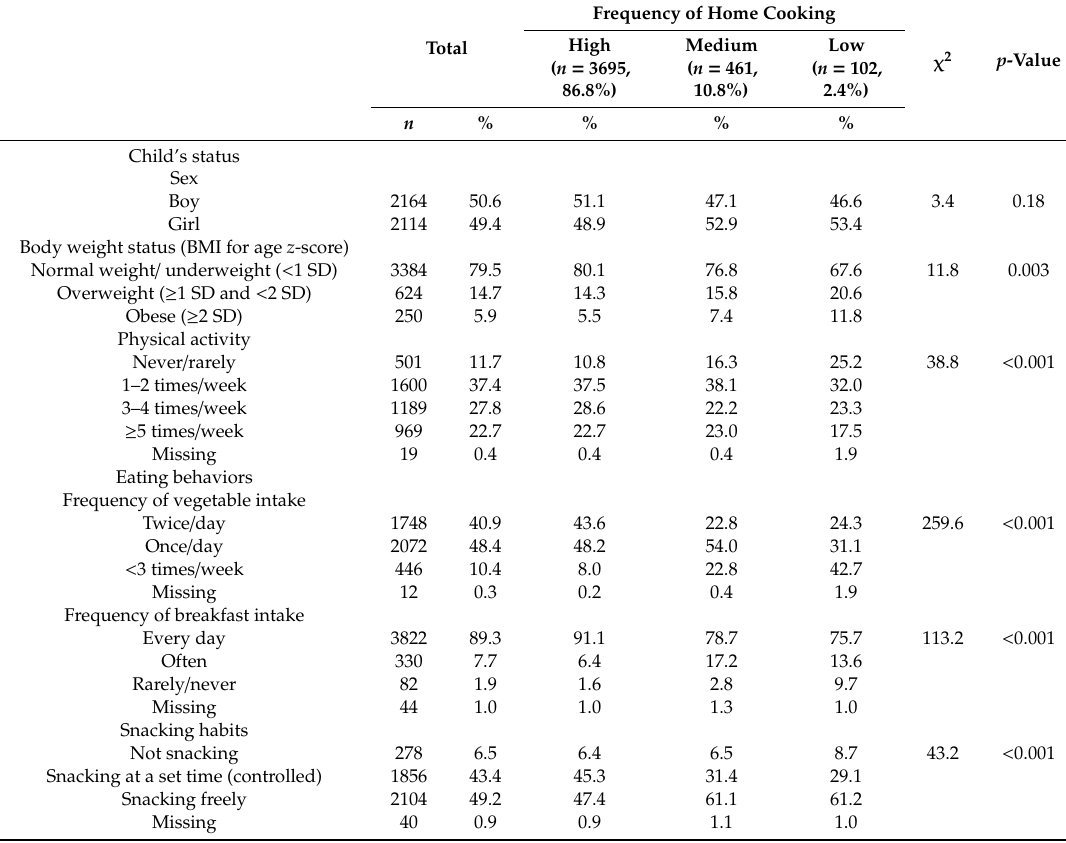
Table 1. Characteristics of participating children ( n =